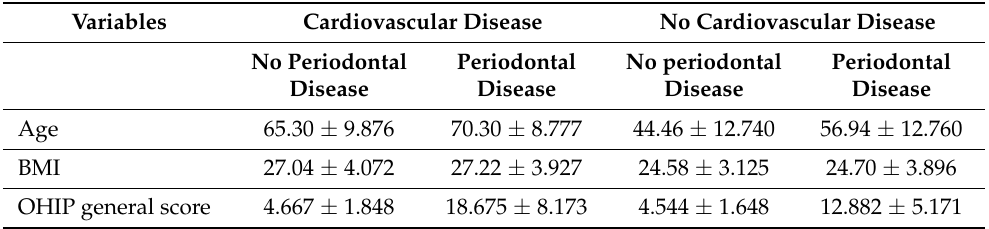
Table 7. OHIP-14 general score and demographic variables in patients with and without periodon- tal